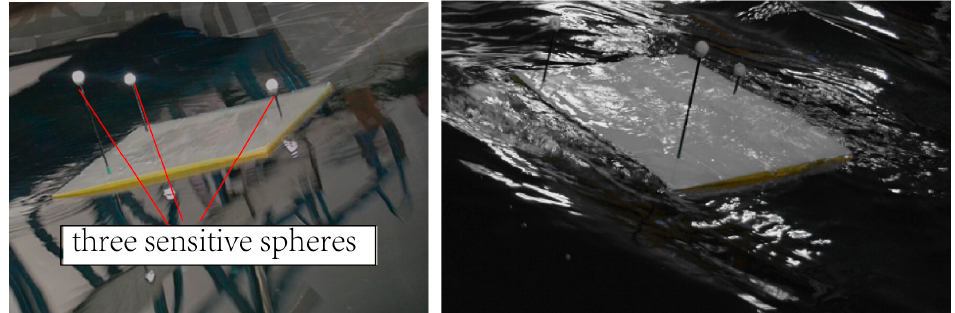
Figure 4. Model ice with sensitive spheres in wave condition. ( Left : Three sensitive spheres; Right : Overwash in the test).